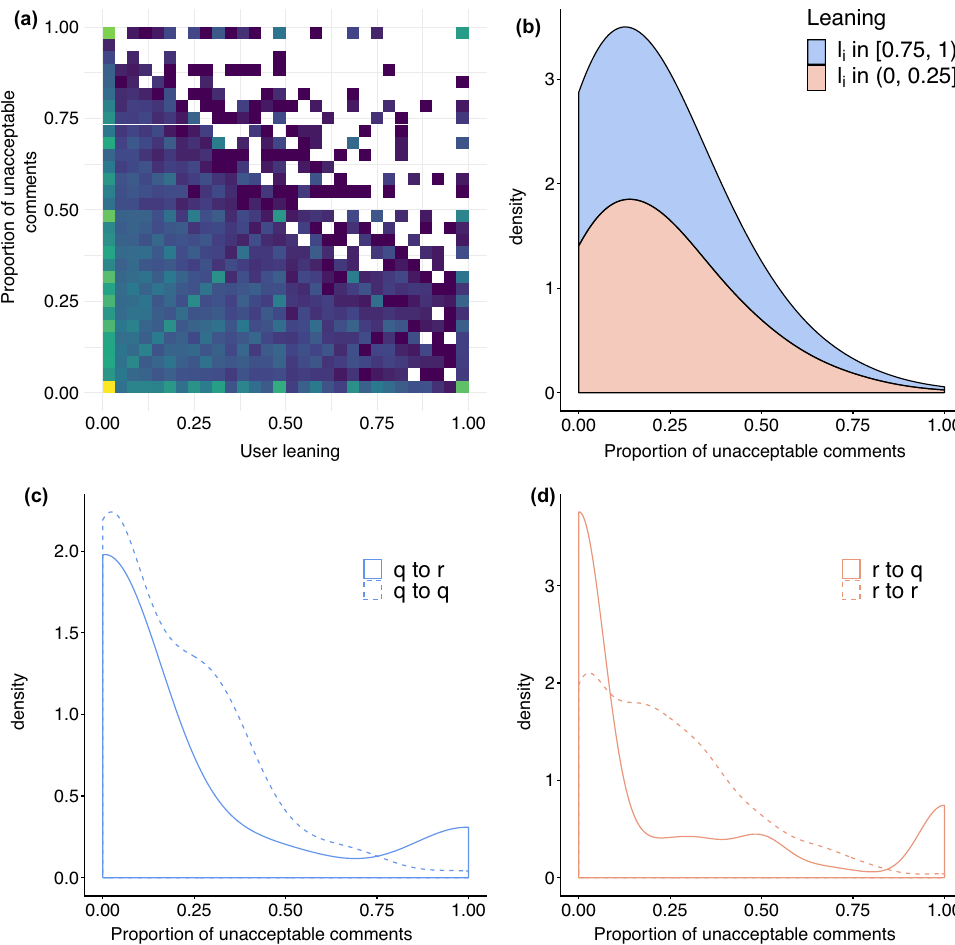
Figure 6. Panel ( a ) displays the relationship occurring between the preference of users for questionable and reliable channels (the user leaning l j ) and the fraction of unacceptable comments posted by the user ( a j ) as a joint distribution. Panel ( b ) displays the distribution of unacceptable comments for users displaying a remarkable tendency to comment under videos posted by questionable ( l j ∈ [ 0.75, 1 ) ) and reliable ( l j ∈ ( 0, 0.25 ] ) channels. Panel ( c ) displays the distribution of unacceptable comments posted by users with leaning towards questionable channels ( l j ∈ [ 0.75, 1 ) indicated as q) under videos of questionable channels (dashed line indicated as q to q in the legend) and under videos of reliable channels (solid line indicated as q to r in the legend). Panel ( d ) displays the distribution of unacceptable comments posted by users with leaning towards reliable channels ( l j ∈ ( 0, 0.25 ] indicated as r) under videos of questionable channels (solid line indicated as r to q in the legend) and under videos of reliable channels (dashed line indicated as r to r in the